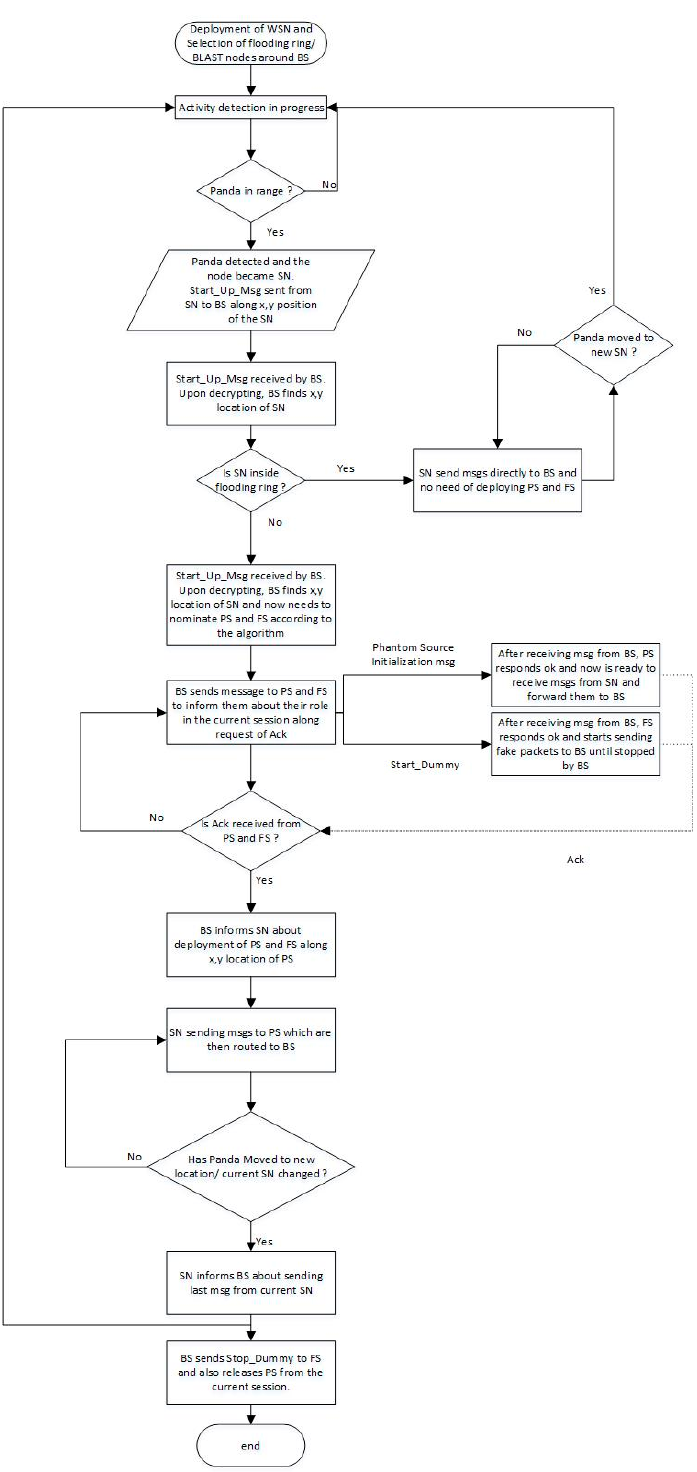
Figure 7. Flow chart of our proposed model.